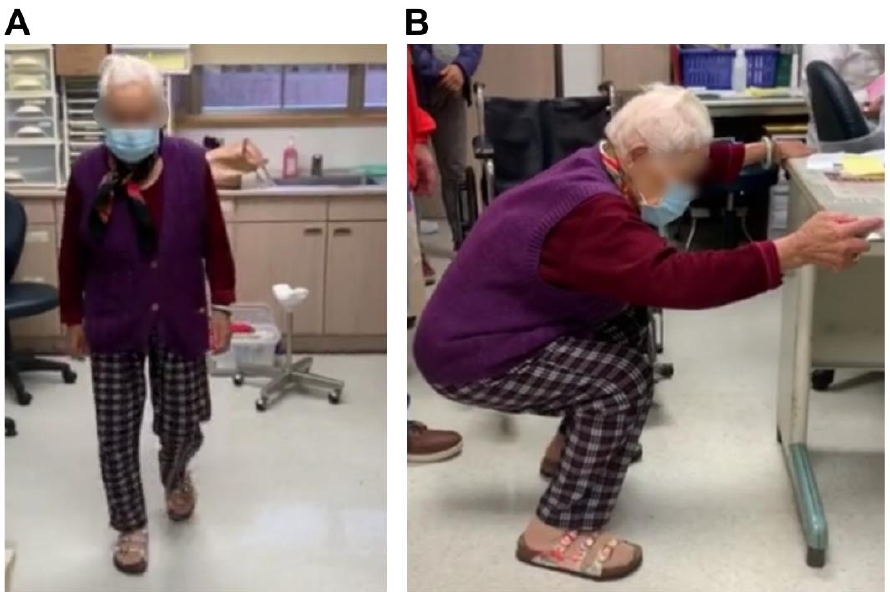
Figure 5. The patient can ( A ) walk without a walker and ( B ) squat while holding a table 4 months after the surgery.